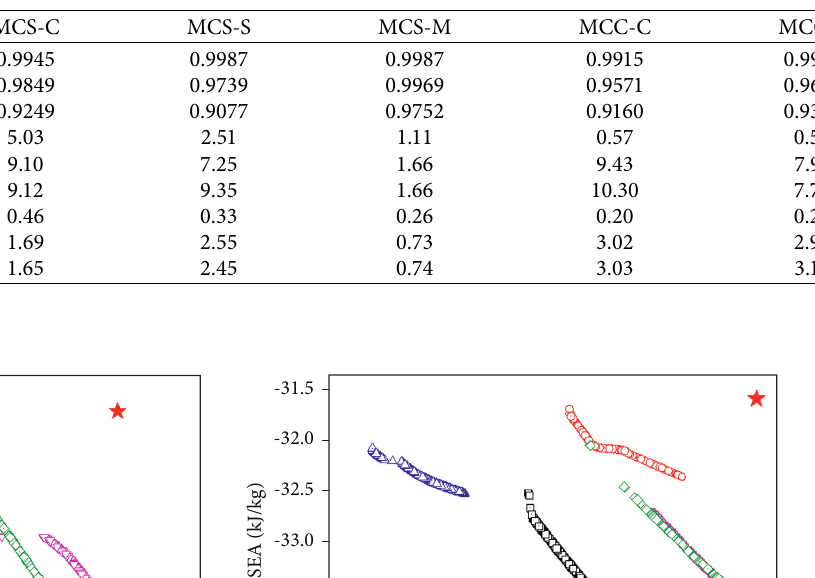
Table 7: Accuracy of the approximate